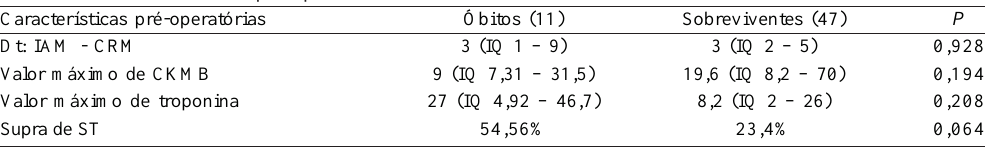
Tabela 1. B. Características pré-operatórias não incluídas no EuroSCORE e no 2000 Bernstein-Parsonnet. Características pré-operatórias